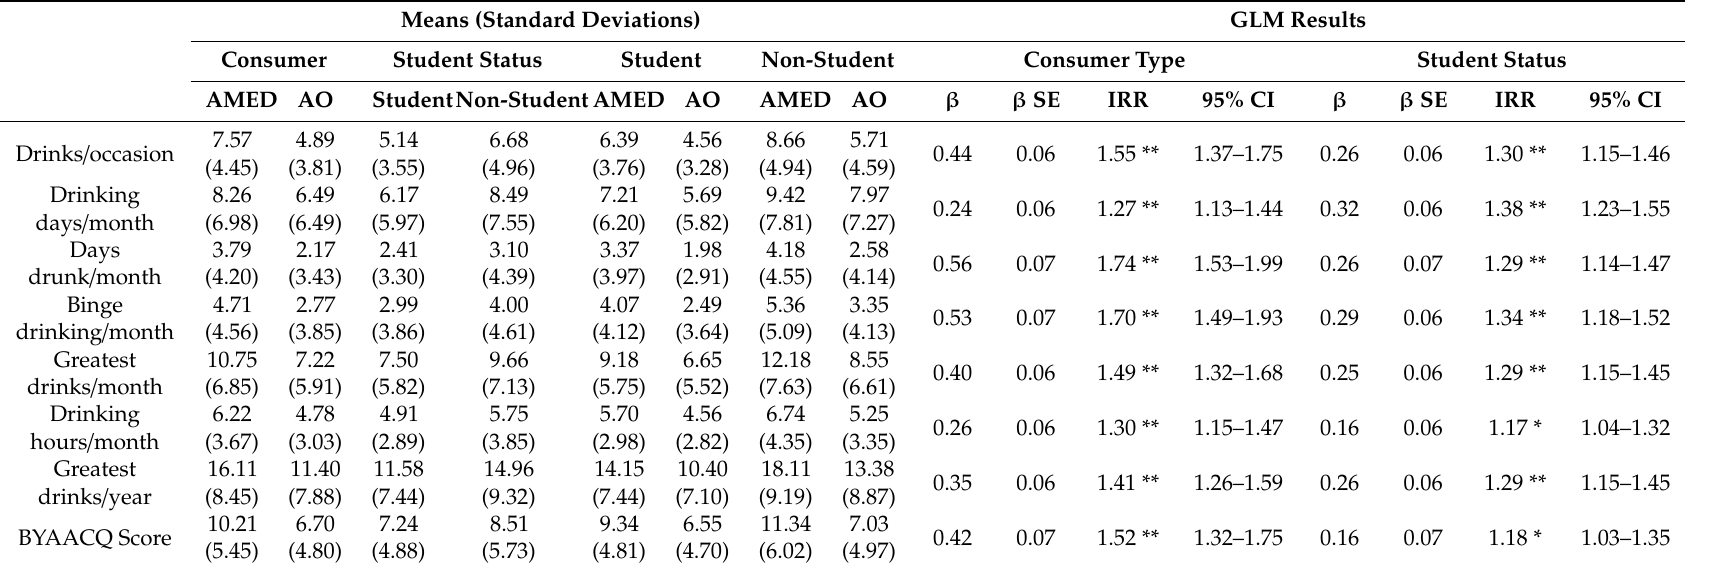
Table 3. Between-subjects comparisons according to consumer type and student status on occasions when alcohol-only was